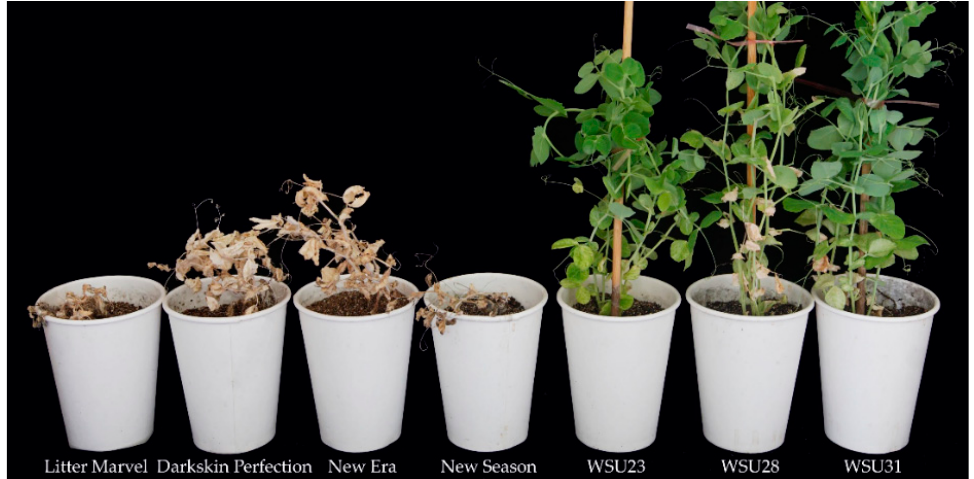
Figure 3. The reaction of pea differential cultivars to the race 5 isolate PF22b of Fusarium oxysporum f. sp. pisi .